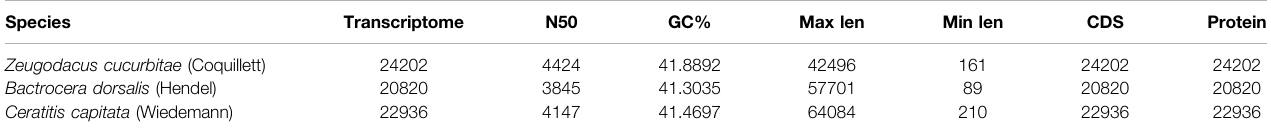
TABLE 1 | Transcriptome data of Zeugodacus cucurbitae (Coquillett), Bactrocera dorsalis (Hendel), and Ceratitis capitata (Wiedemann). Species